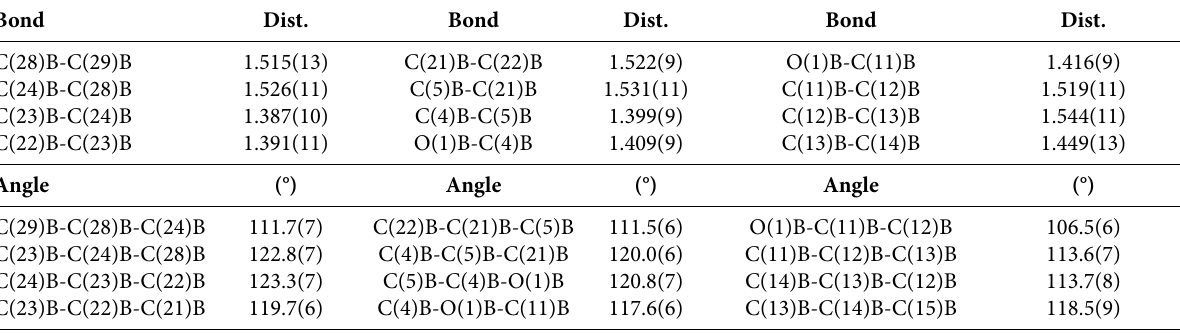
Fig. 2. Packing diagram of the C6A-C10-OH with 50% probability level ellipsoids Table 2. Selected Bond Lengths (Å) and Bond Angles (°) for the C6A-C10-OH Bond Dist. Bond Dist. Bond